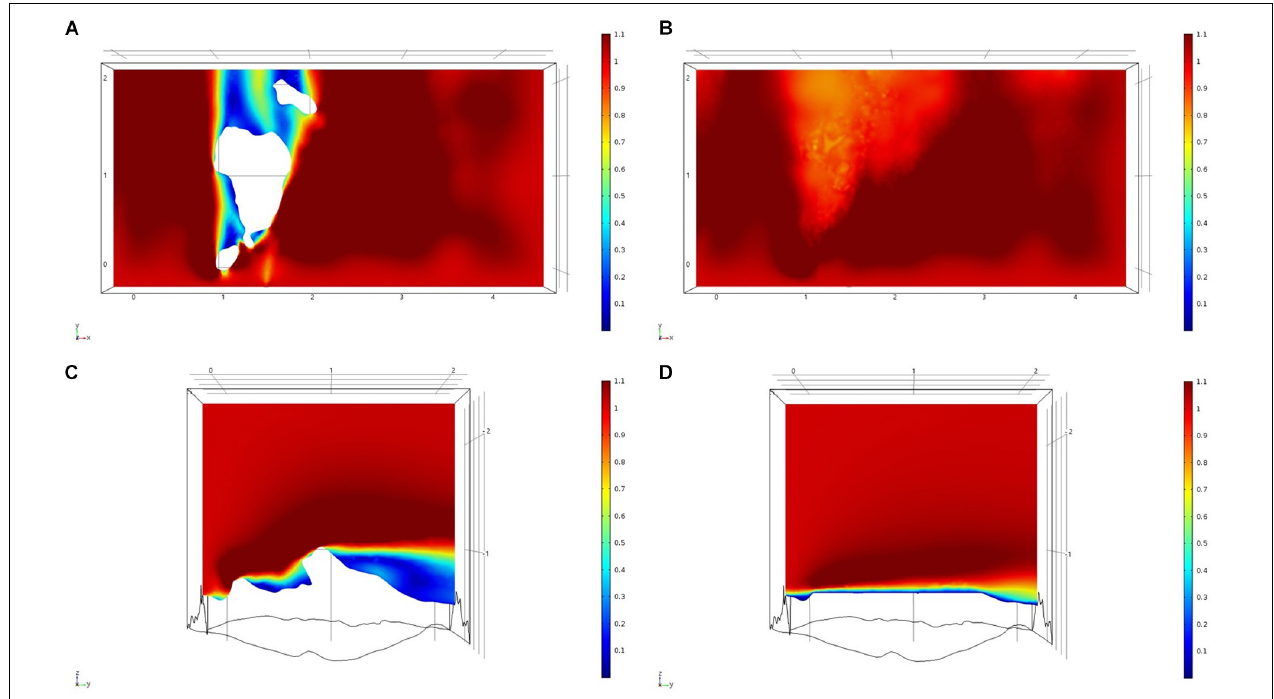
FIGURE 10 | Results of the fluid flow finite element analysis simulation for surface models for GOK Study area visualized as two-dimensional plots (horizontal and vertical cross sections) of flow velocity magnitude (false-color scales m/s). (A,C) Surface model with sponges present. (B,D) Surface model with sponge structures removed. Scale in m with ambient flow of 1 m/s along the y